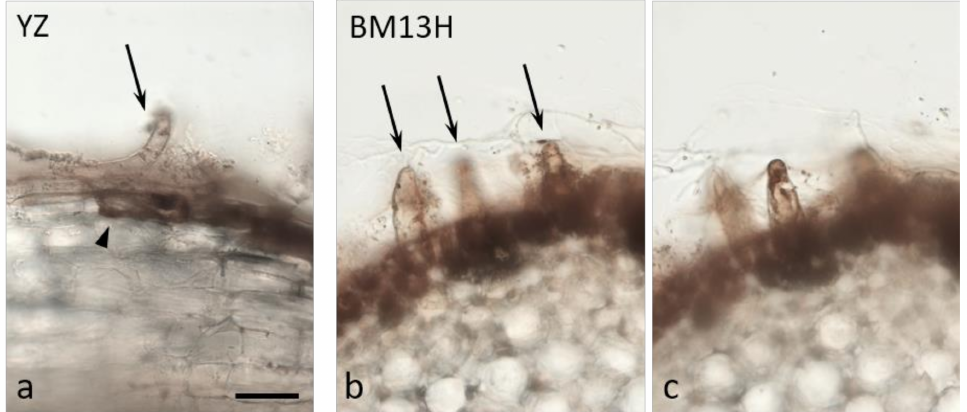
Figure 5. Cross-sections of roots from susceptible (YZ— a ) and resistant (BM13H— b , c ) G. arboreum seedlings 10 days after inoculation with BRR spores in sterile culture. Epidermal cells (arrowhead in a) and root hairs (arrows) are heavily colonized with dark fungal hyphae. ( b , c ) are different optical sections of the same root cross-section. Bar in a for a – c = 50